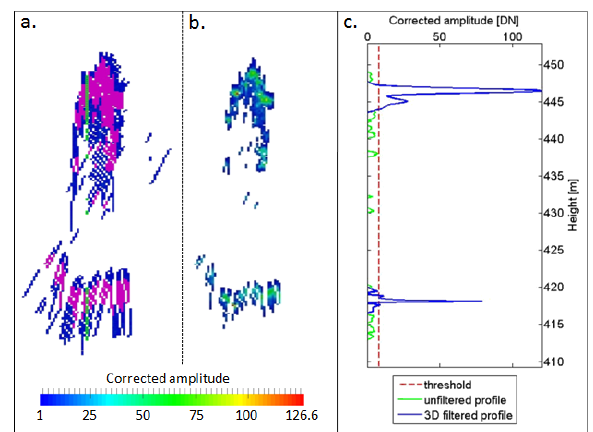
Figure 14. Results of 3D filtering: vertical slice of unfiltered and filtered voxel space overlaid (a), vertical slice of filtered voxel space coloured by attributes (b), profiles of a column (c) Nevertheless, there are still remaining noise voxel below the ground which have to be eliminated. For instance, this could be obtained by detecting the digital terrain model from the voxel space and neglecting all voxel below